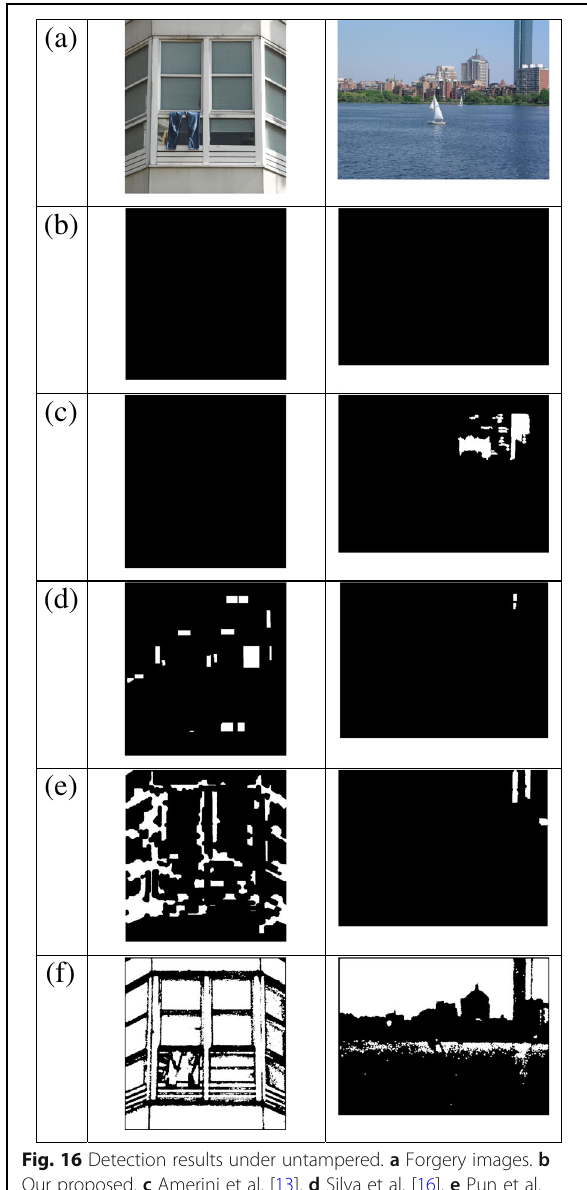
Fig. 16 Detection results under untampered. a Forgery images. b Our proposed. c Amerini et al. [13]. d Silva et al. [16]. e Pun et al. [18]. f Li et al. [19]